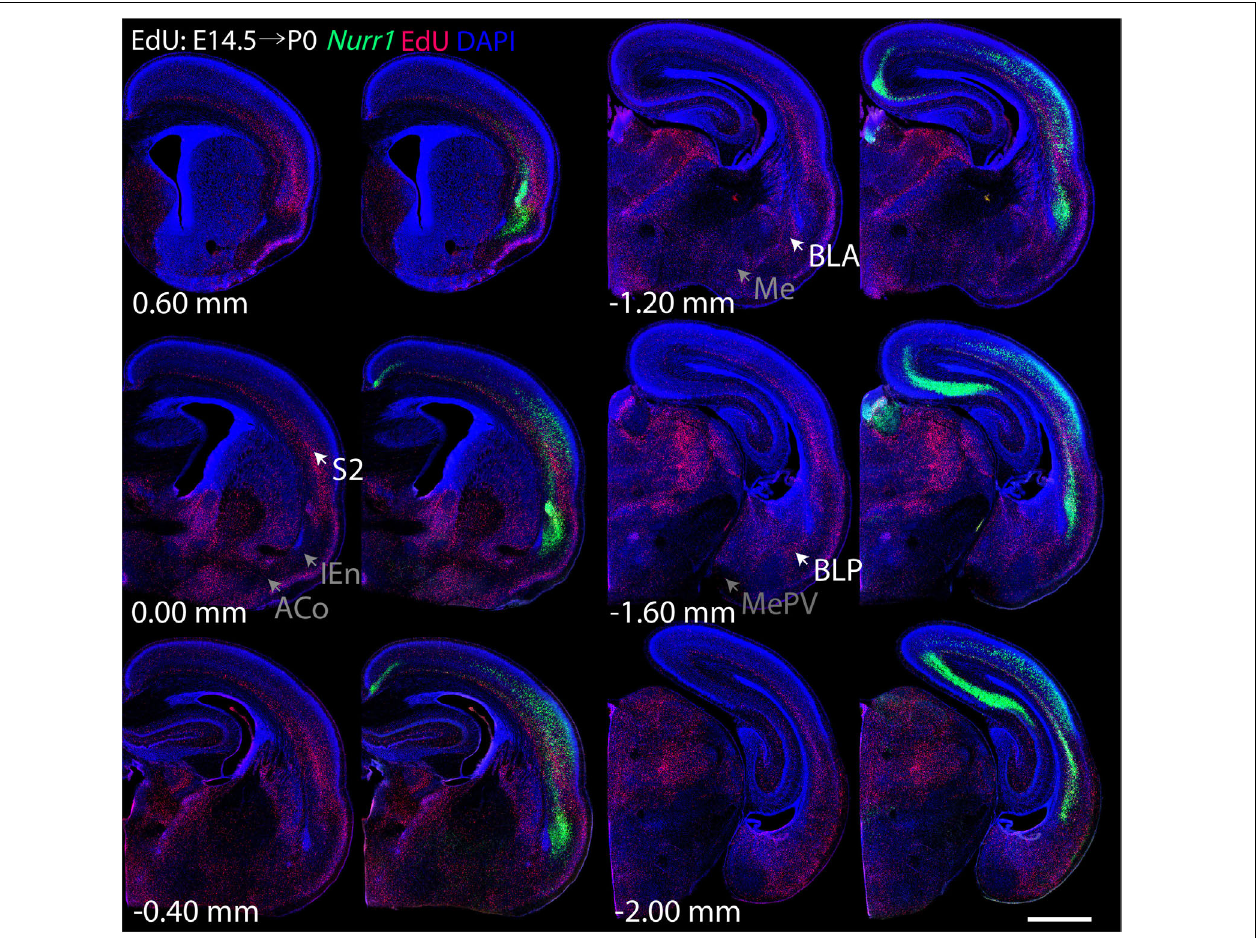
FIGURE 6 | Overview of EdU labeling on E14.5 with Nurr1 FISH on P0. White arrows indicate the EdU labeled regions. Gray arrows indicate the regions with reduced EdU labeling. S2, secondary somatosensory cortex, BLA basolateral amygdaloid nucleus, anterior part, BLP basolateral amygdaloid nucleus, posterior part, IEn, intermediate endopiriform nucleus, ACo anterior cortical amygdaloid area, Me, medial amygdaloid nucleus, MePV, medial amygdaloid nucleus, posteroventral part. Numbers below sections indicate the bregma coordinate. N = 3 rats. Scale bar = 1